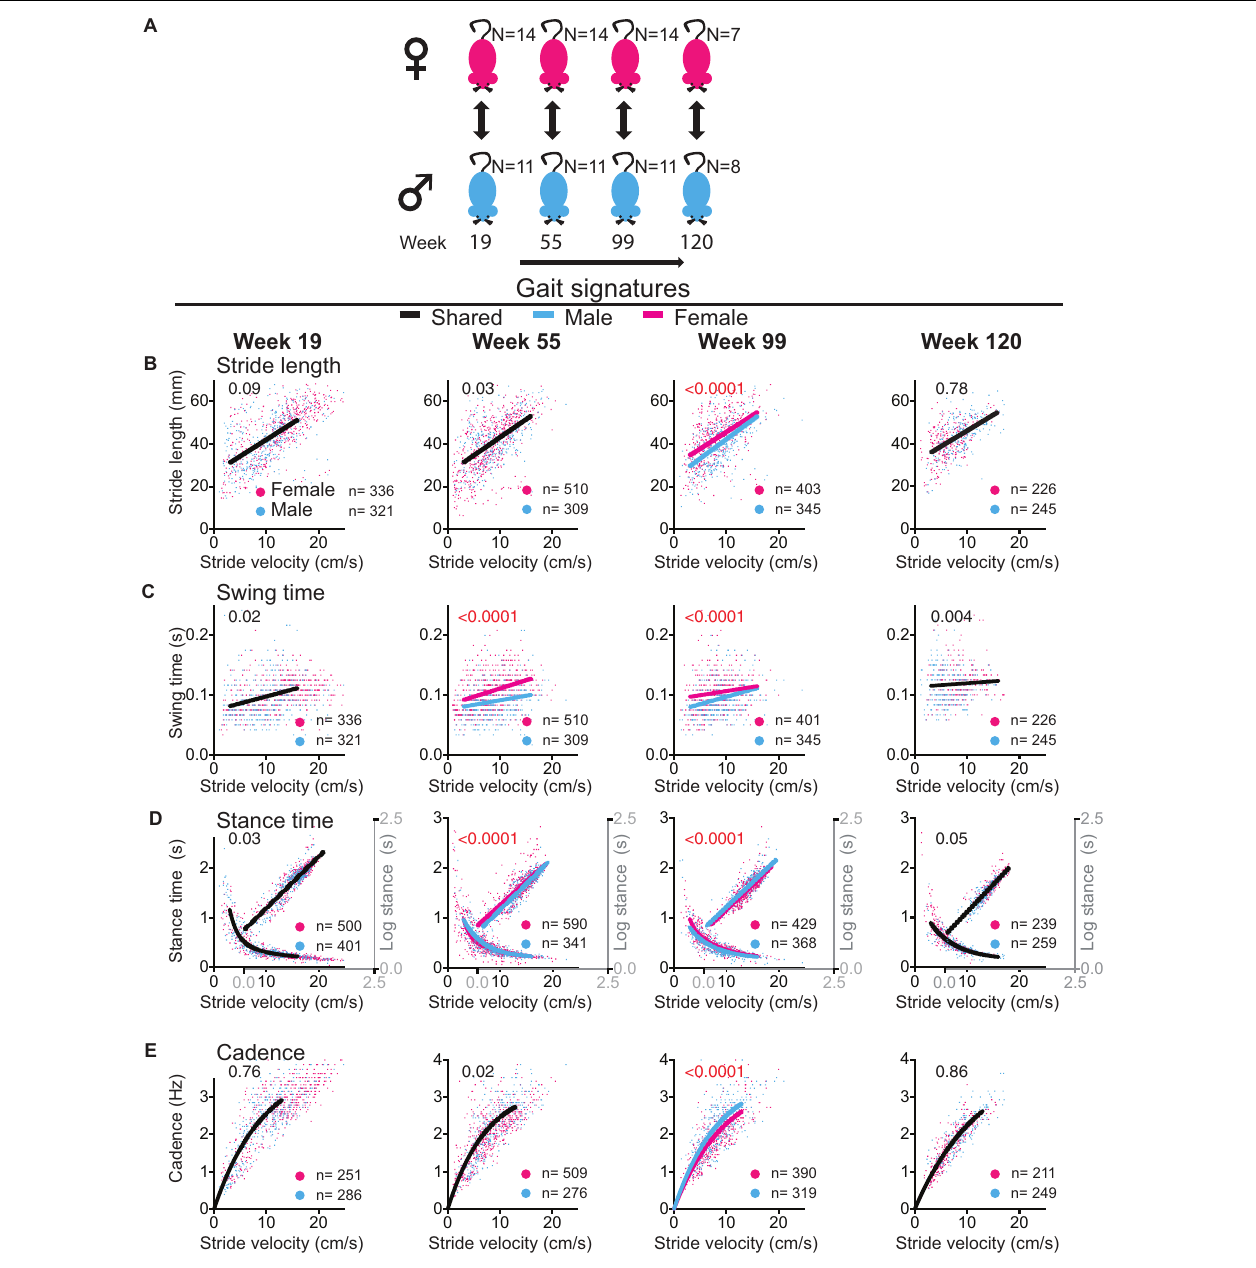
FIGURE 5 | Sex differences in gait signatures during aging. (A) Experimental paradigm for comparisons between female (magenta) and male (blue) mice. (B–E) Stride by stride gait metrics stride length (B) , swing time (C) , stance time (D) , and cadence (E) plotted as a function of stride by stride velocity. Single curves or lines indicate that the female and male datasets fit the same curve, whereas separate lines indicate that datasets are significantly different (Sum of square F -test; alpha 0.001). Note that males and females share curves at the mature adult (week 19) and geriatric (week 120) time points, but that sex differences exist in swing time at middle age (week 55) and all metrics at old age (week 99). Curves were fitted for the velocity range that represents walking gait. N , number of mice; n , number of strides included in the analysis. Statistical analyses are summarized in Supplementary Table 4 .